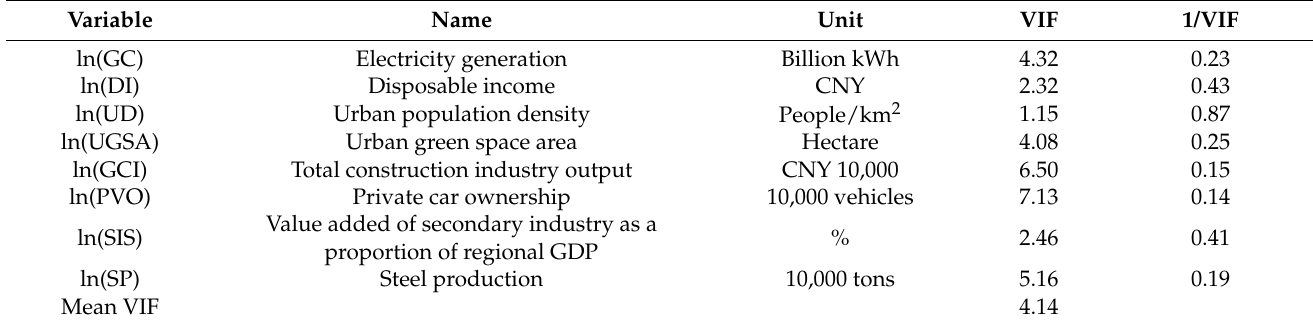
Table 2. Collinearity test results.